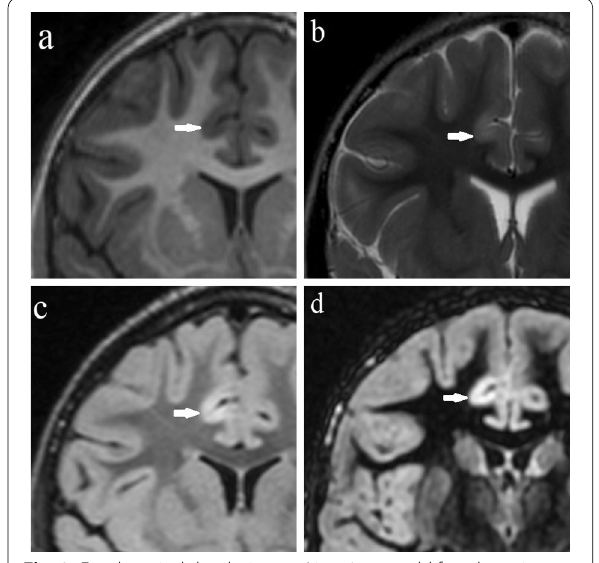
Fig. 2 Focal cortical dysplasia type I in a 9 years old female patient. Coronal T1 ( a ), T2 ( b ), FLAIR ( c ) and DIR ( d ) images. T1 shows subtle hypointense signal (arrow in a ). Also, T2 and FLAIR show increased cortical thickness and hyperintense signal (arrows in b , c ). The high signal intensity and increased cortical thickness are most conspicuous on the DIR image (arrow in d )